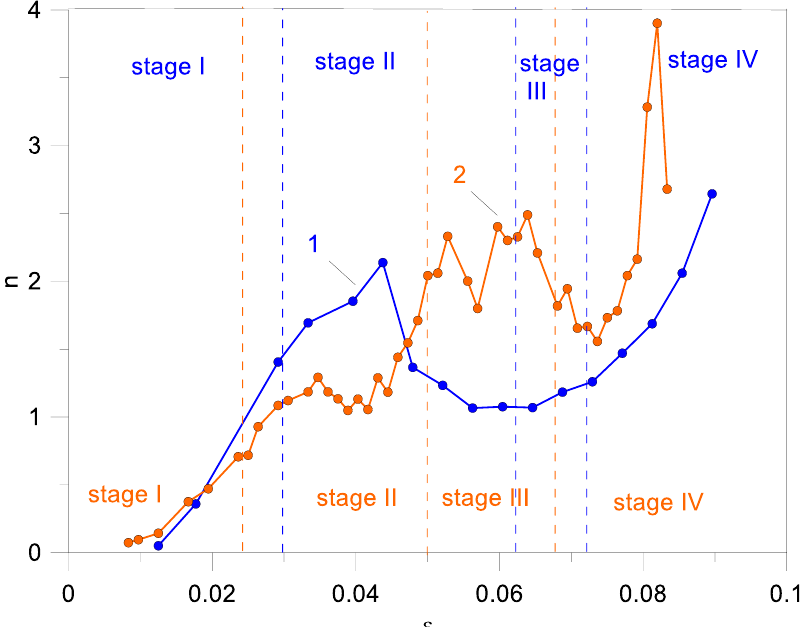
Figure 20. Evolution of n = ε xx / ε yy ratio with inelastic strain. Sample #1 (1) and Sample #2 (2) data are shown.